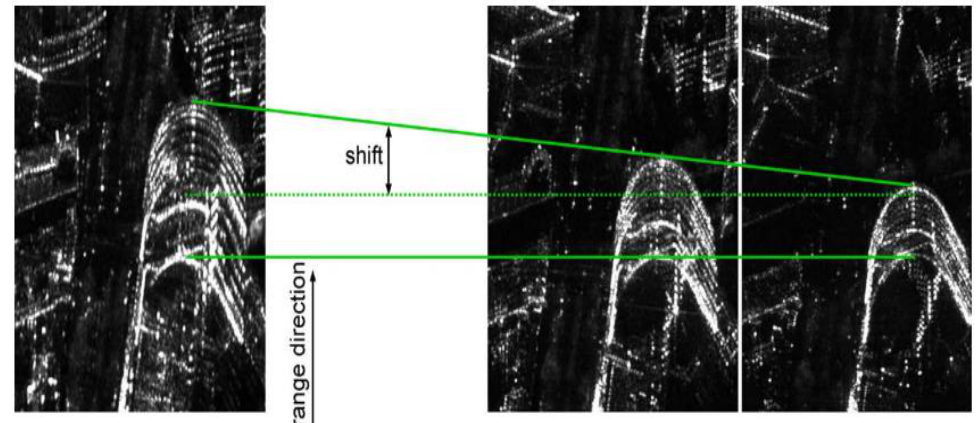
Figure 2. TerraSAR-X images of Swissotel Berlin, taken from view angles of 27.1°, 37.8°, and 45.8° from left to right, respectively.